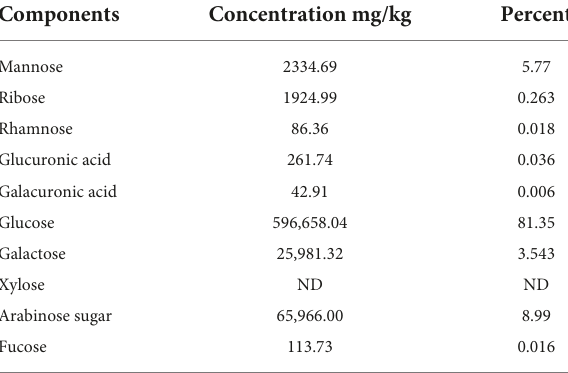
TABLE 1 Monosaccharide composition of M. esculenta crude polysaccharide (MEP).